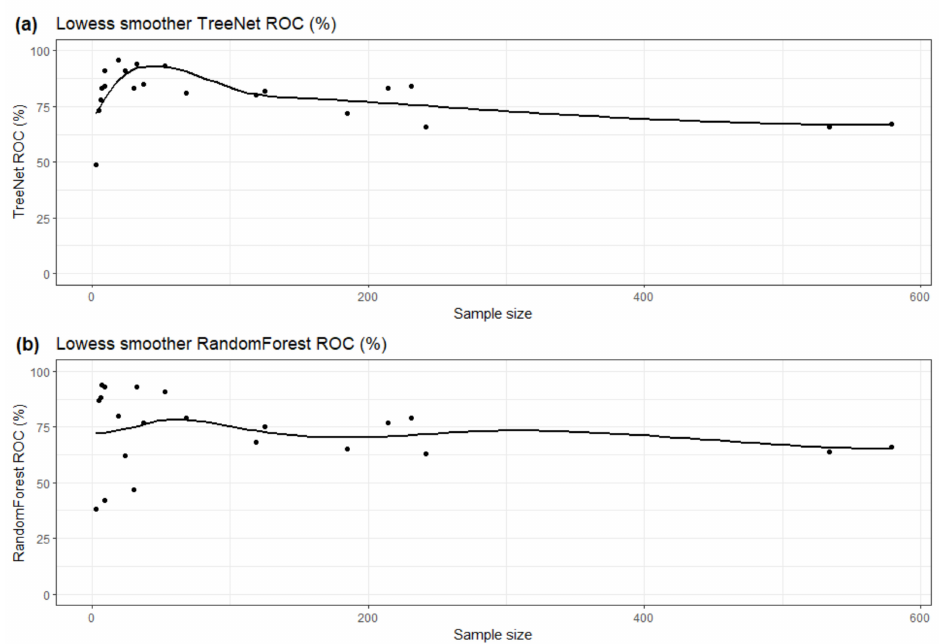
Figure 5. Evaluation of the quality of the TreeNet ( a ) and RandomForest ( b ) models underlying the Sample size and relative ROC